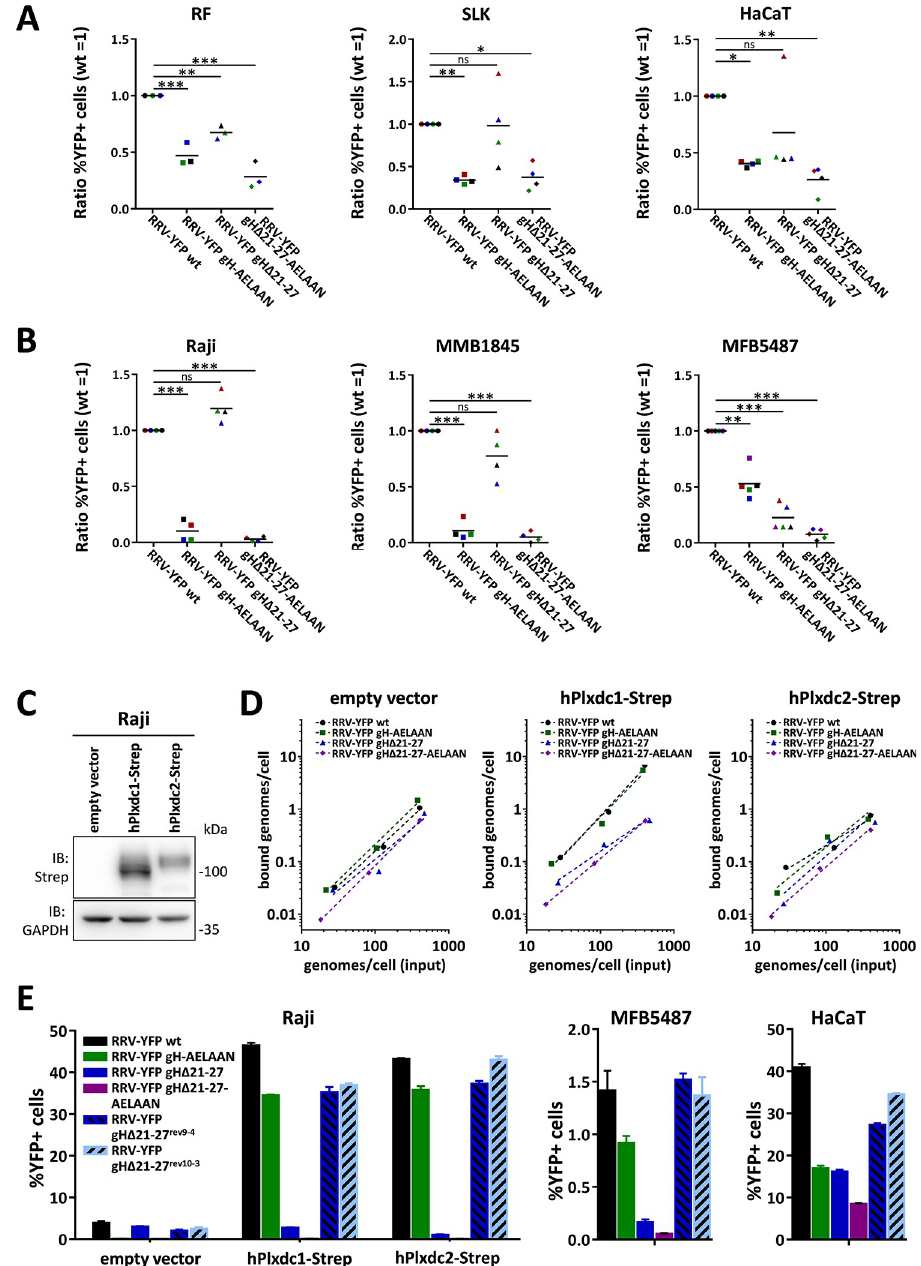
Fig 5. The contribution of the RRV 26–95 gH-Plxdc interaction to infection is cell type-specific and may in part be dependent on attachment effects. A) RRV 26–95 deleted in the Plxdc interaction motif exhibits reduced specific infectivity on HaCaT and RF, but not SLK cells. Target cells were infected with RRV-YFP wt, RRV-YFP gH-AELAAN, RRV-YFP gH Δ 21–27 or RRV-YFP gH Δ 21-27-AELAAN normalized to genome copies as determined by qPCR. YFP expression as indicator of infection was measured by flow cytometry and normalized to RRV-YFP wt infection. Means of individual normalized infections with three (RF) or four (HaCaT, SLK) independent sets of RRV stocks are given as symbols of different color. Sets with RRV-YFP wt infection in an MOI range of 0.05–1 were used for analysis. The mean across the independent sets of RRV stocks is indicated by black lines. B) RRV 26–95 deleted in the Plxdc interaction motif exhibits reduced specific infectivity on MFB5487, but not Raji and MMB1845 cells. Target cells were infected with RRV-YFP wt, RRV-YFP gH-AELAAN, RRV-YFP gH Δ 21–27 or RRV-YFP gH Δ 21-27-AELAAN normalized to genome copies as determined by qPCR. YFP expression as indicator of infection was measured by flow cytometry and normalized to RRV-YFP wt infection. Means of individual normalized infections with four